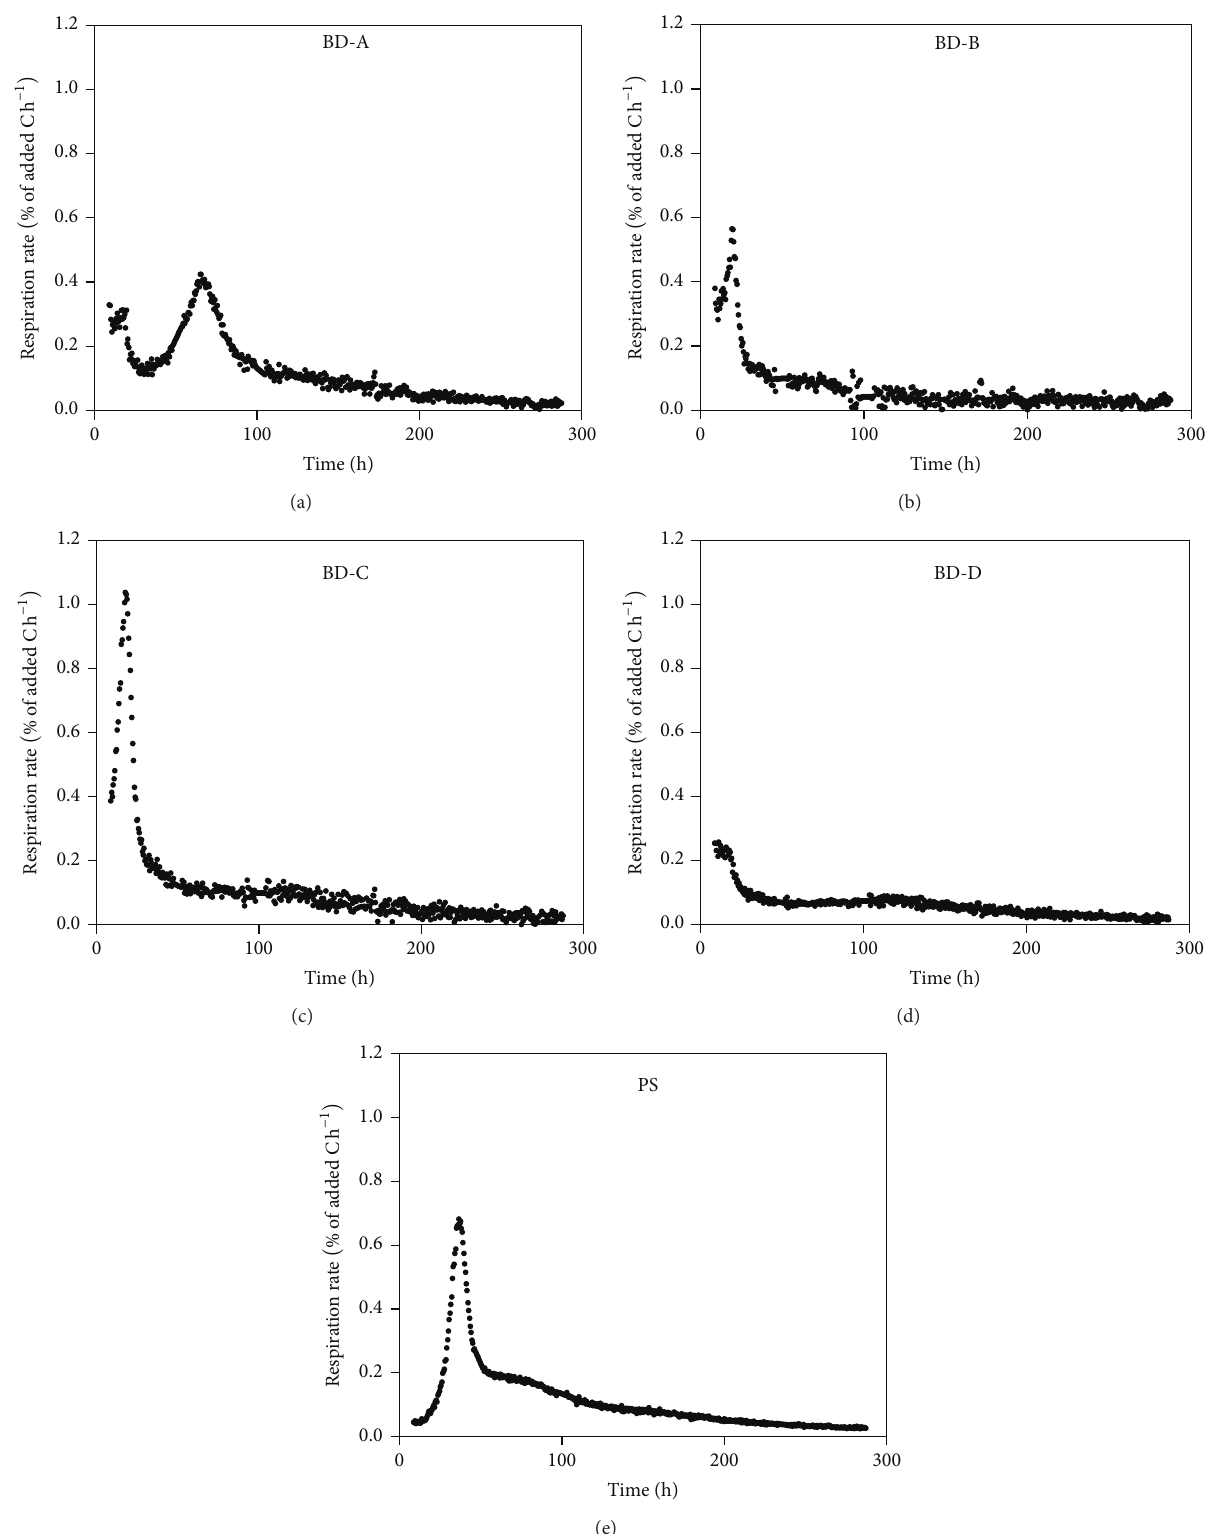
Figure 1: Soil respiration rate after amendment with four types of biogas residues (BD-A, BD-B, BD-C, and BD-D) and pig slurry (PS) at rates corresponding to 140kg NH 4+ -Nha −1 (mean, 𝑛 = 4